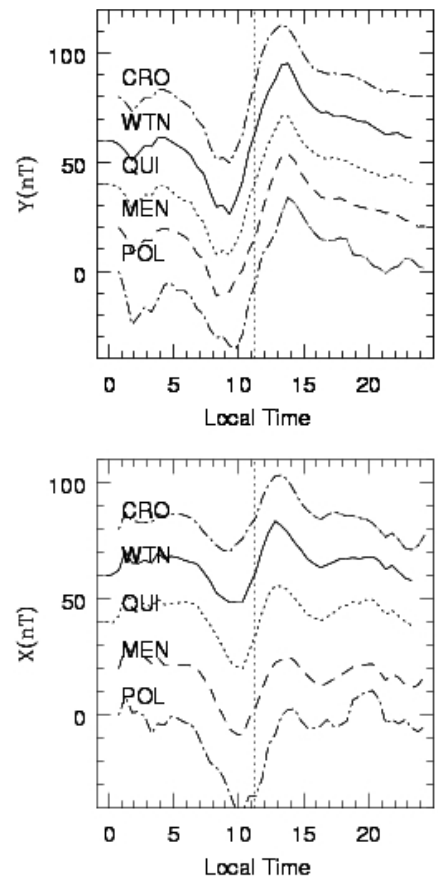
Fig 8. Magnetic variations from 15 May 1990, plotted every half hour, as for Fig 2. Fig. 8. Magnetic variations from 15 May 1990, plotted every half hour, as for Fig.